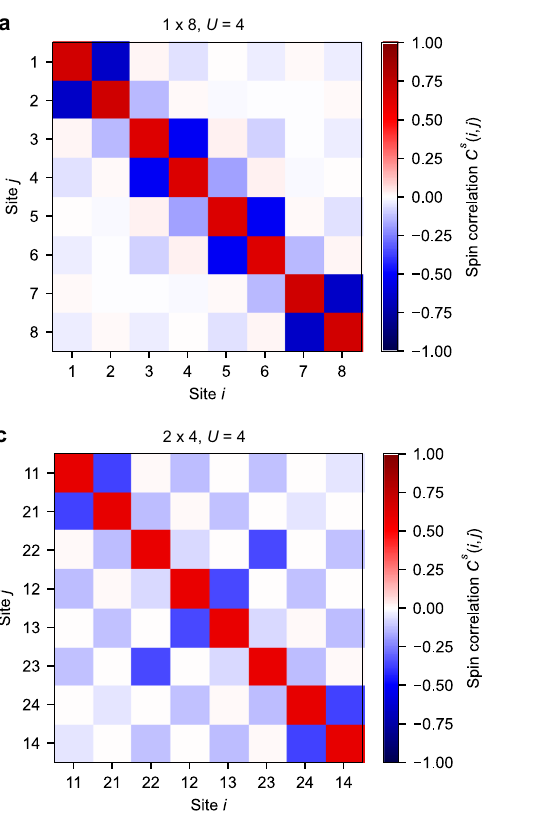
Fig. 6 | Antiferromagnetic correlations at half- fi lling ( U =4) obtained with the quantumprocessor.a , c Spincorrelationfunction C s ( i , j )fora1×8( a )and2×4( c ) instance of the Fermi-Hubbard model. The ordering of sites for the 2×4 lattice